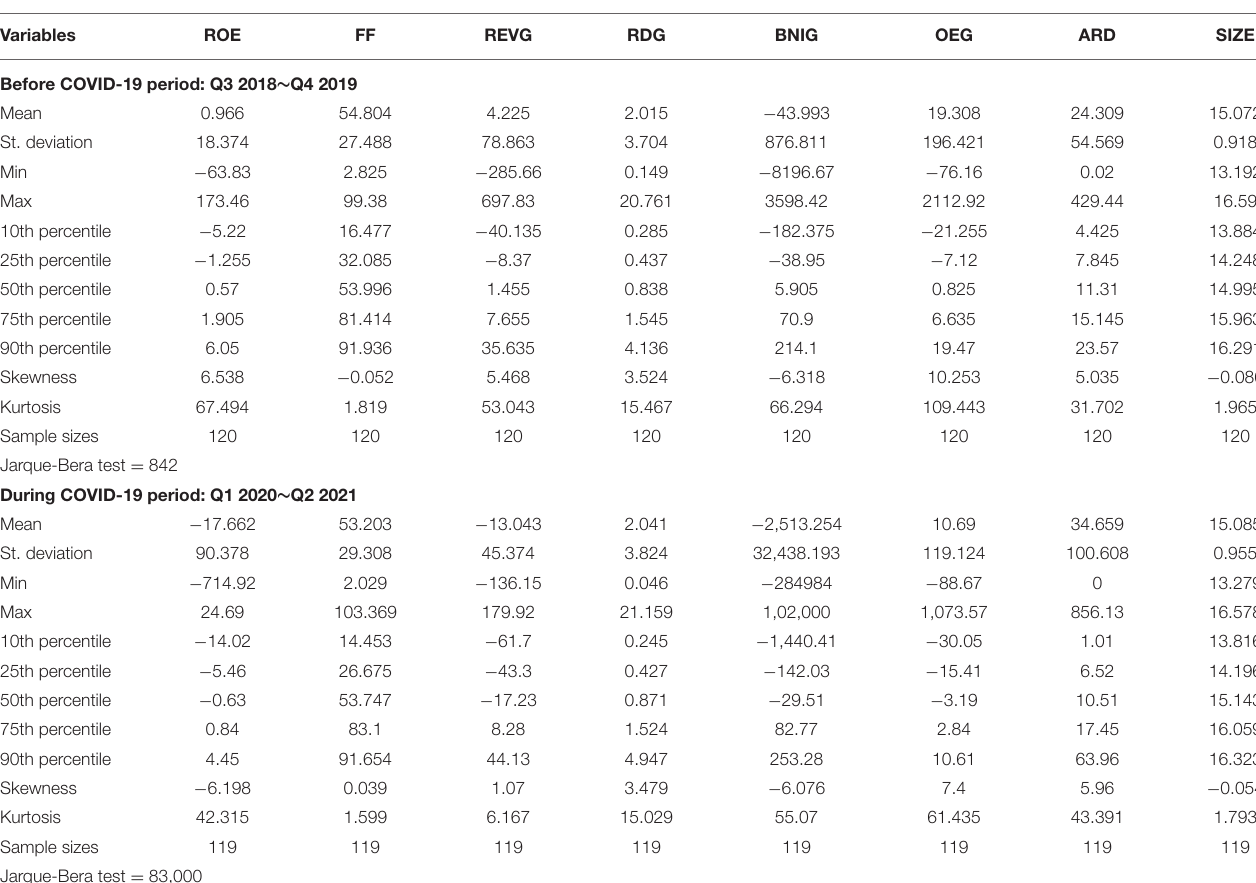
TABLE 1 | Summary